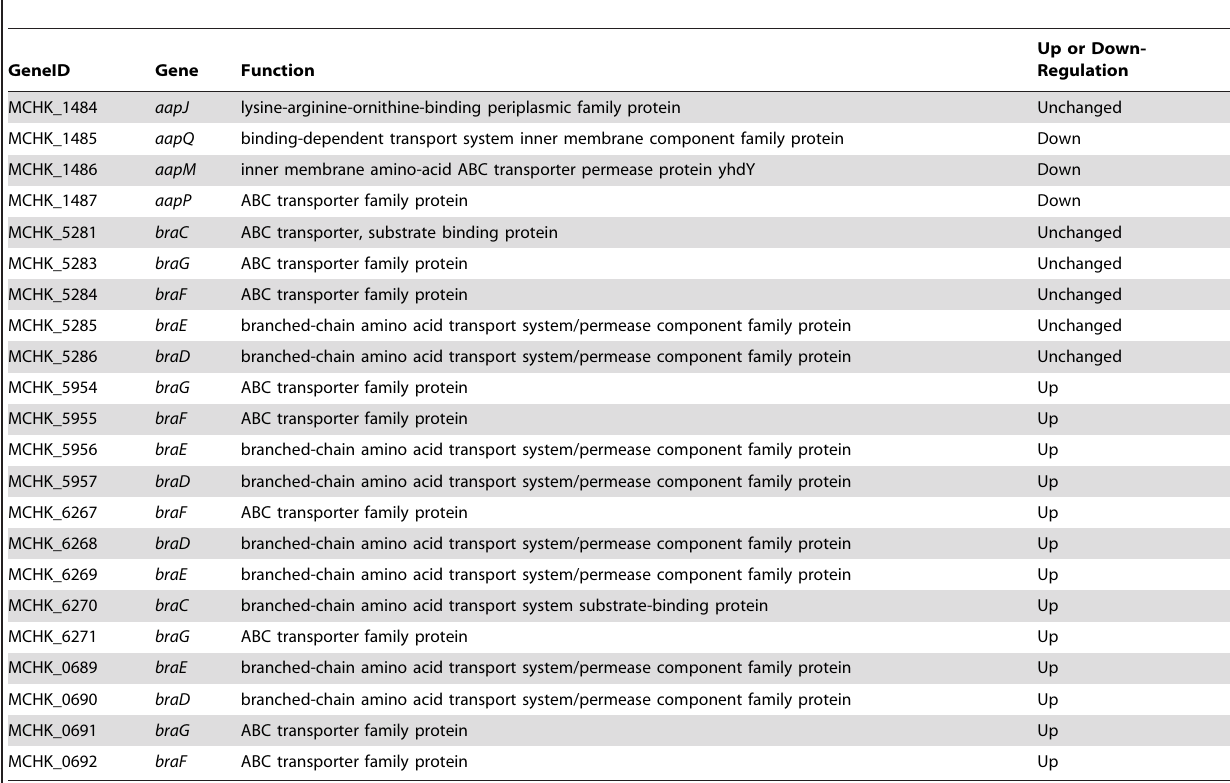
Table 2. Genes associated with branched-chain amino acid transport in M. huakuii 7653R.